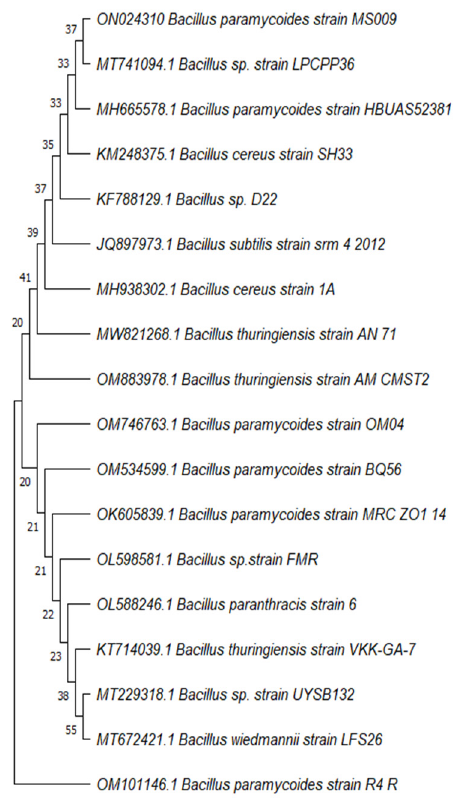
Figure 1. Phylogenetic tree comparing the MS009 isolate to the closely related Bacillus species. This was constructed using the MEGA package, version 11, based on 16S rDNA using the neighbor-joining and minimum evolution tree methods, with bootstrap values based on 1000 replications. The MS009 partial 16S rDNA was deposited in GenBank under accession no.